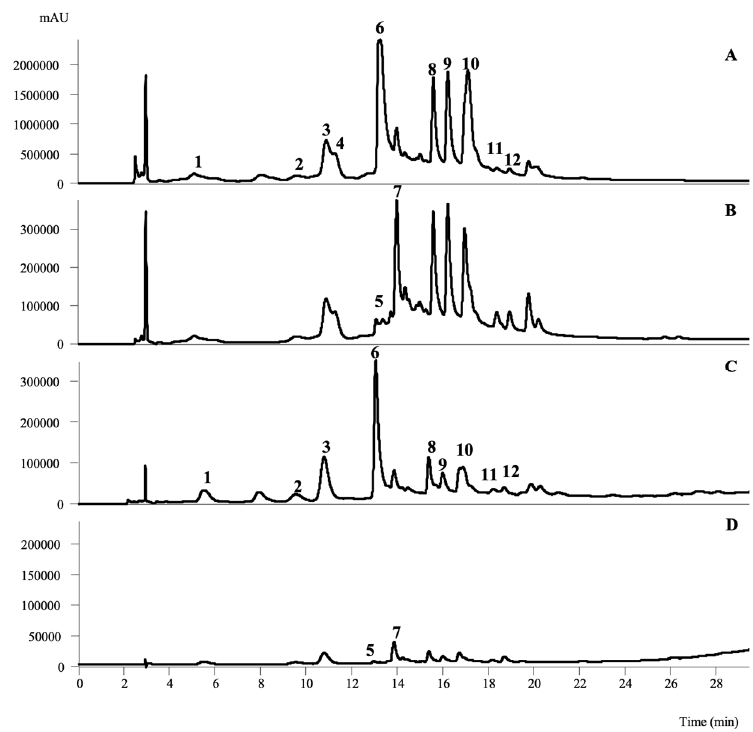
Figure 3. Phenolic profile of the infusion ( A , B ) and ethanolic ( C , D ) extracts of Artemisia gorgonum were recorded at 280 nm ( A , C ) and 370 nm ( B , D ), respectively. The identified peak number corresponds to the following compounds: 1 . 3 ‐ O ‐ caffeoylquinic acid; 2. 4 ‐ O ‐ caffeoylquinic acid; 3 . Cis 5 ‐ O ‐ caffeoylquinic acid; 4 . Trans 5 ‐ O ‐ caffeoylquinic acid; 5 . Apigenin ‐ 6 ‐ C ‐ Glc ‐ 4 ″‐ O ‐ Glc (isosaponarin); 6 . Melilotoside; 7 . Apigenin ‐ 6 ‐ C ‐ Ara ‐ 8 ‐ C ‐ Glc (schftoside); 8 . 4 ‐ di ‐ O ‐ caffeoylquinic acid; 9 . 3,5 ‐ di ‐ O ‐ caffeoylquinic acid; 10 . 4,5 ‐ di ‐ O ‐ caffeoylquinic acid; 11 . Cis 3,4 ‐ di ‐ O ‐ caffeoylquinic acid; 12 . Trans 3,4 ‐ di ‐ O ‐ caffeoylquinic acid [19].